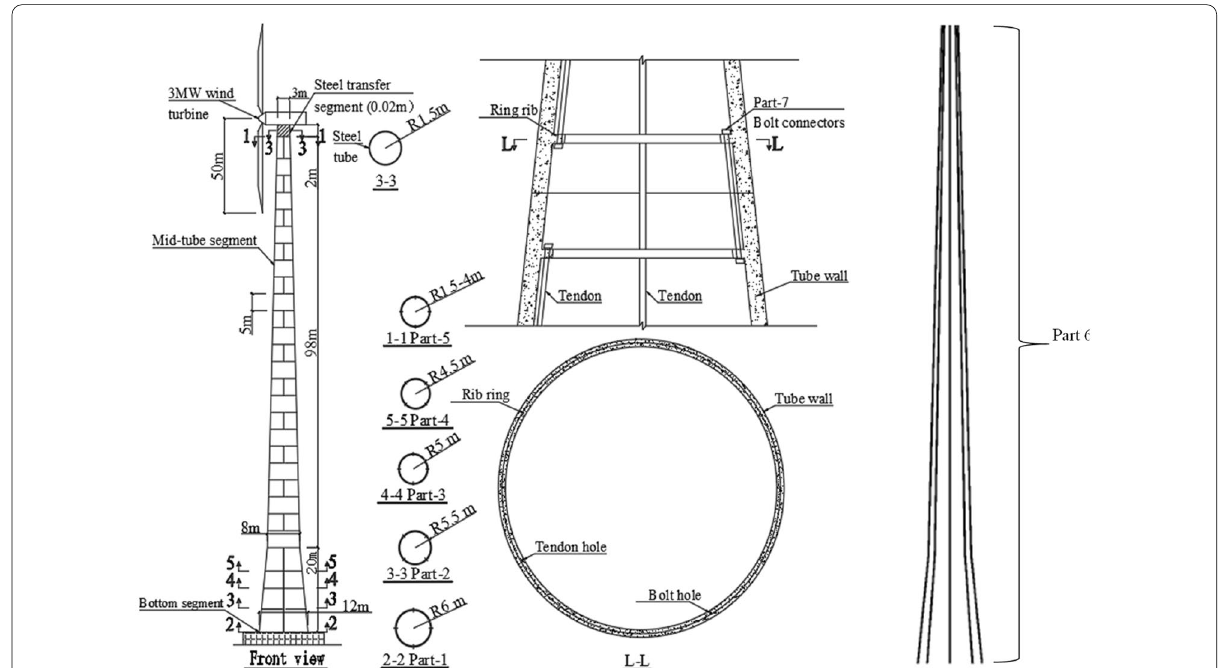
Fig. 1 Main part and detailed local diagram of the